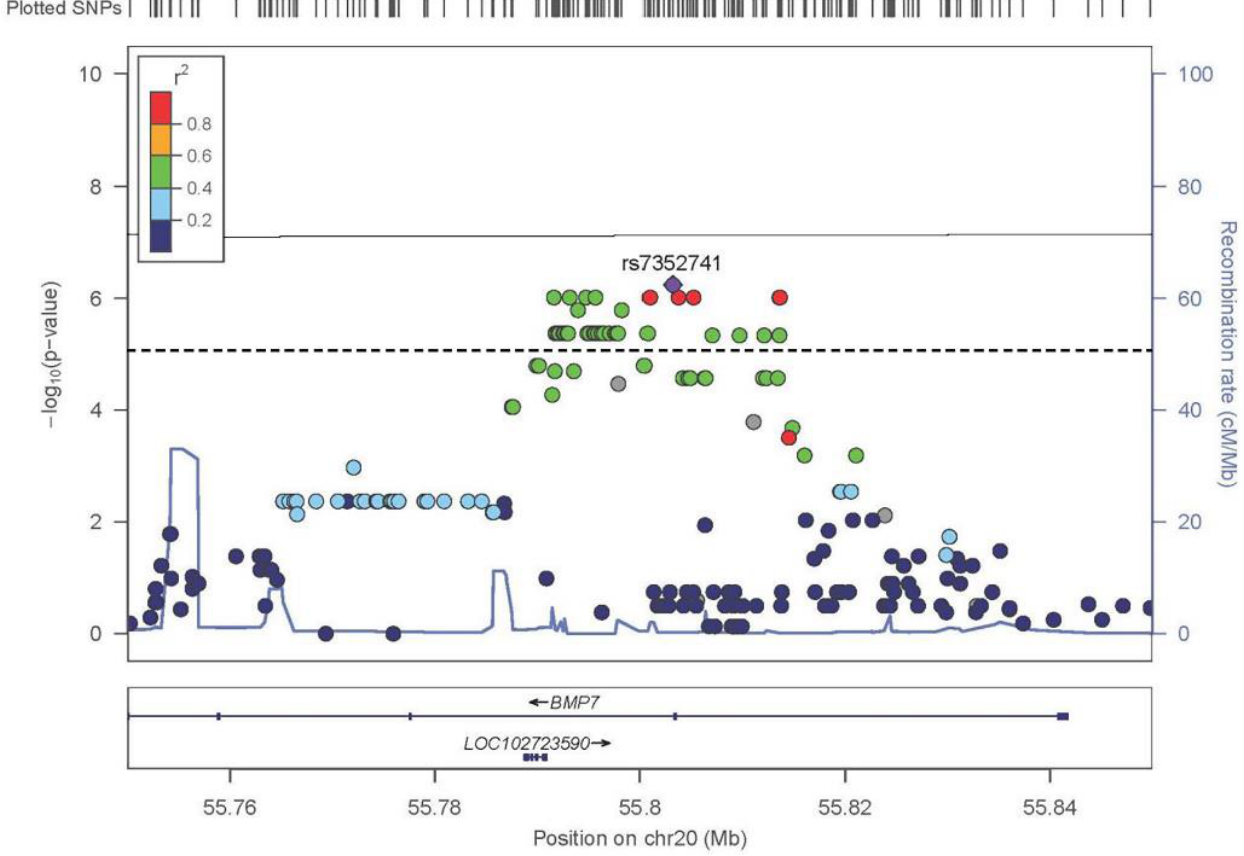
Figure 4. The results of the TDT for the metopic synostosis when only the 20 most informative trios are included. Here, the line represents the genome-wide suggestive threshold of 1.00 × 10 − 5 and the genome-wide significant threshold of 5.00 × 10 − 8 . The LD ( r 2 ) between the most significantly associated SNV rs7352741 ( p = 5.73 × 10 − 7 ) and other SNVs are indicated. LD, linkage disequilibrium; SNV, single nucleotide variant; TDT, transmission disequilibrium